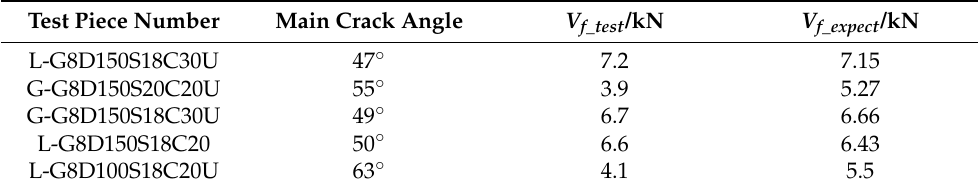
Figure 10. V f Fitting curve between experimental value and theoretical value V f . 3.5.3. Comparison of Experimental Values and Theoretical Values Table 10 shows the comparison between the theoretical value and the experimental value of the five reinforced specimens with shear failure. It can be seen from the data in the table that the ratio of the experimental practical value to the theoretical value of the two specimens is less than 1, but the difference is within 5%. The specimens with bending failure and the ultimate bearing capacity are more significant than or like the shear failure test specimens, so it is still safe to calculate the shear-bearing capacity of the oblique sec- tion according to the above formula. In summary, the calculation formula of the shear capacity of the reinforced concrete T-beam, reinforced with FRP embedded in the surface, can be written as follows: θεϕ λ